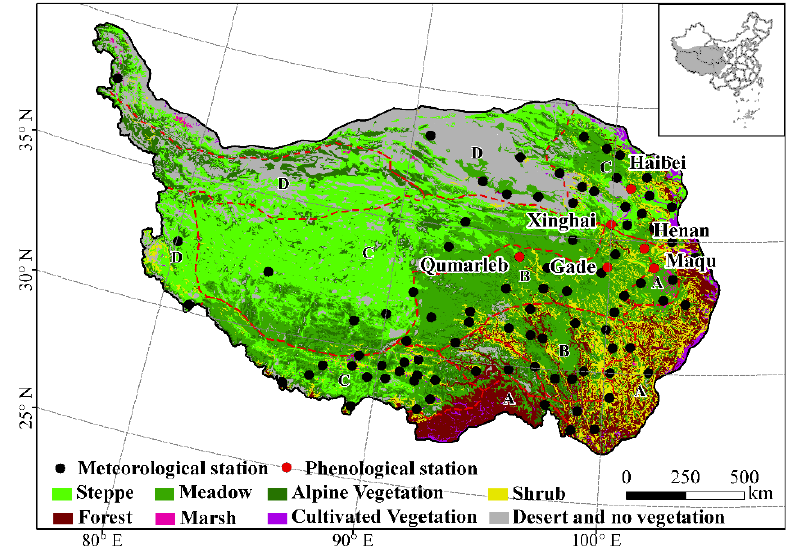
Figure 2. Spatial distribution of major vegetation types and meteorological and phenological stations on the Qinghai-Tibet Plateau (QTP). The red dashed line denotes boundaries of climatic subdivisions [26]. A, B, C, and D represent humid, sub-humid, semi-arid, and arid regions, respectively.